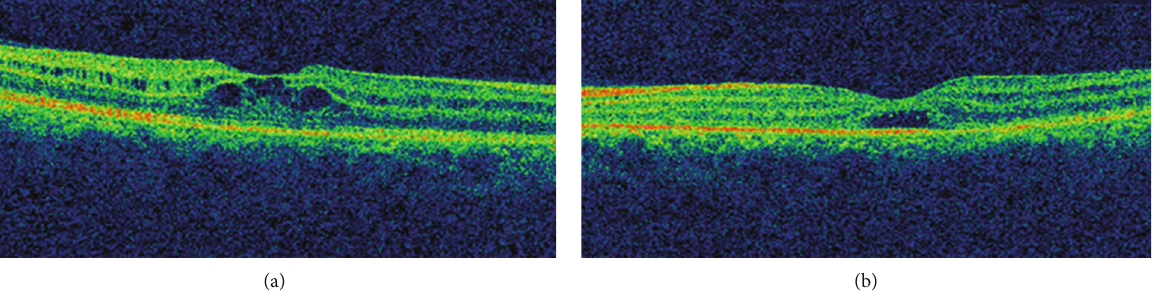
Figure 3: SD-OCT at four weeks following lightning injury. (a) Right eye with intraretinal cystoid changes. (b) Left eye with a foveal cyst. The cyst has increased fl uid volume compared to OCT at presentation.